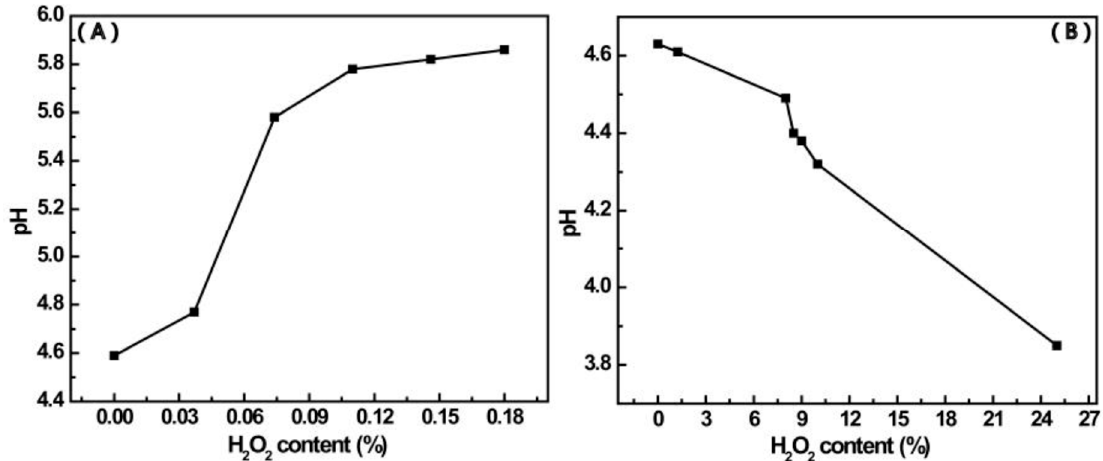
Figure 6. The change in pH of the mixtures containing a different ratio of 4 ‐ MPBA to H 2 O 2 with the content of H 2 O 2 . ( A ) A higher ratioof 4 ‐ MPBA to H 2 O 2 (1.87 mM 4 ‐ MPBA, 0~0.18% H 2 O 2 ); ( B ) a lower ratio of 4 ‐ MPBA to H 2 O 2 (0.58 mM 4 ‐ MPBA, 0~25% H 2 O 2 ).